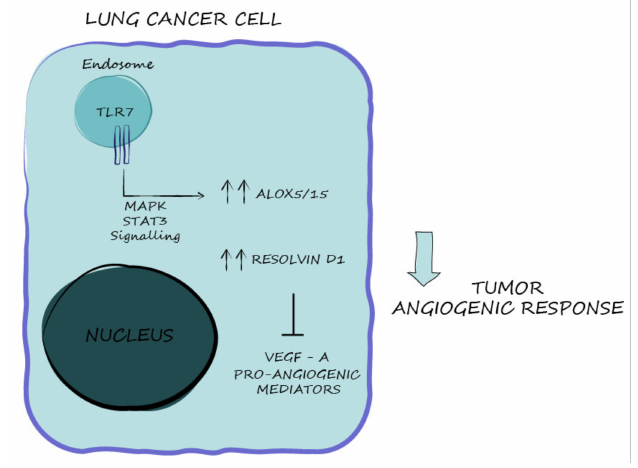
Figure 7. Schematic representation of mechanisms involved in TLR7-mediated angiogenic